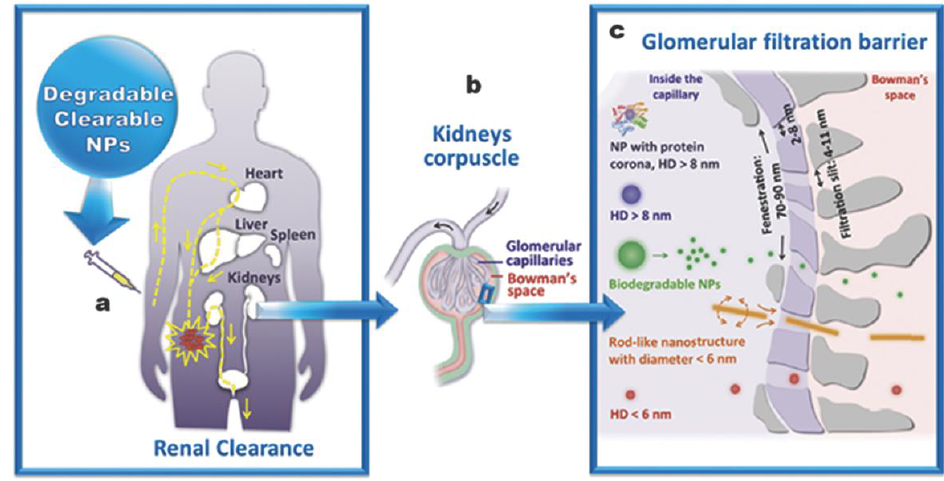
Figure 1. ( a ): Major organs involved in the biodistribution of nanoparticles. ( b , c ): Schematic glomerular clearance possibilities depending on the biodegradability and size of nanoparticles. Adapted from reference [34] with